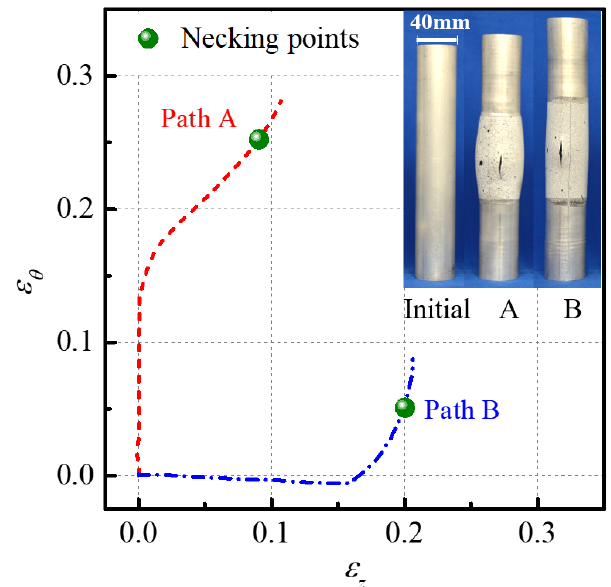
Figure 8. Necking points and strain paths of the AA6061 tube under nonlinear loading paths.